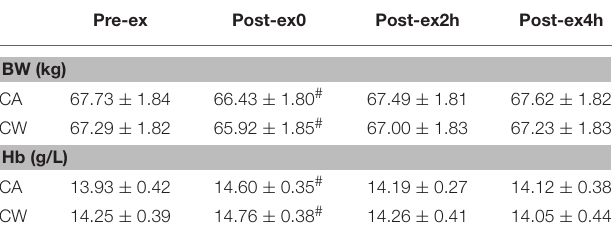
Post-ex4h, the salivary cortisol was lower than Pre-ex in CA